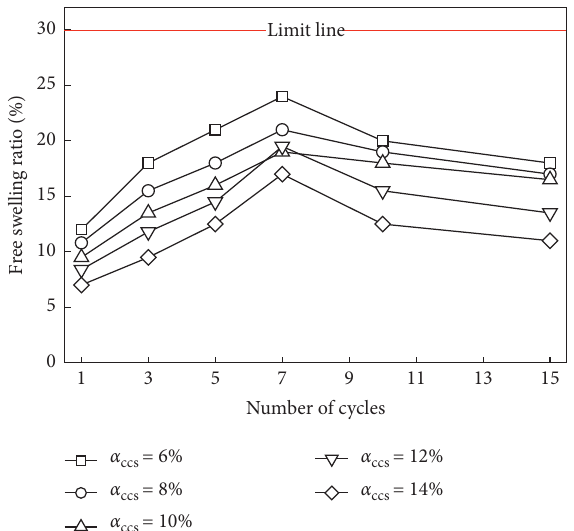
Figure 1: Free swelling ratio during the drying-wetting process.